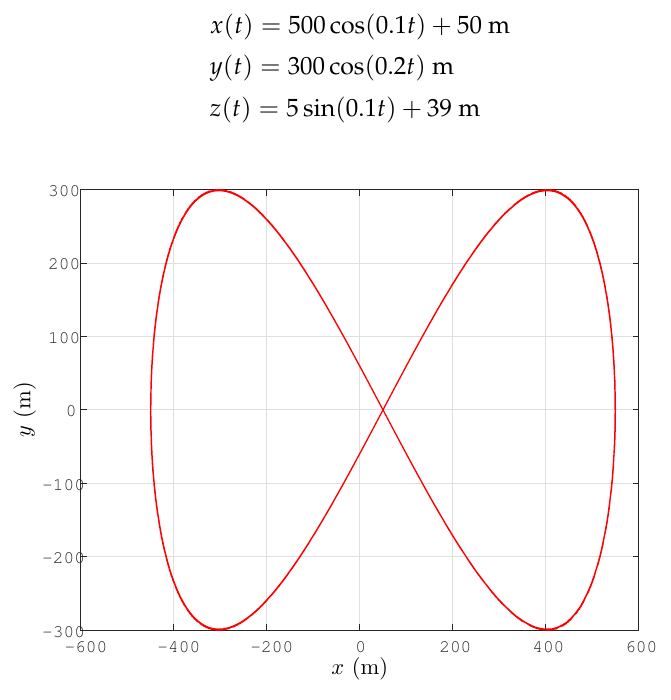
Figure 3. Lateral trajectory ( x ( t ) , y ( t )) (m) (or ( x [ k ] , y [ k ]) ) of the